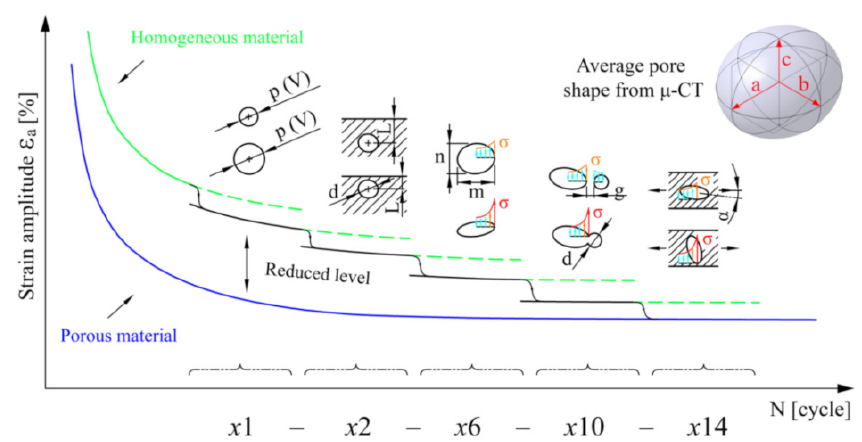
Figure 4. Individual, porosity-adjusted shifts of the C–M curves are a better strategy for predicting the fatigue life.